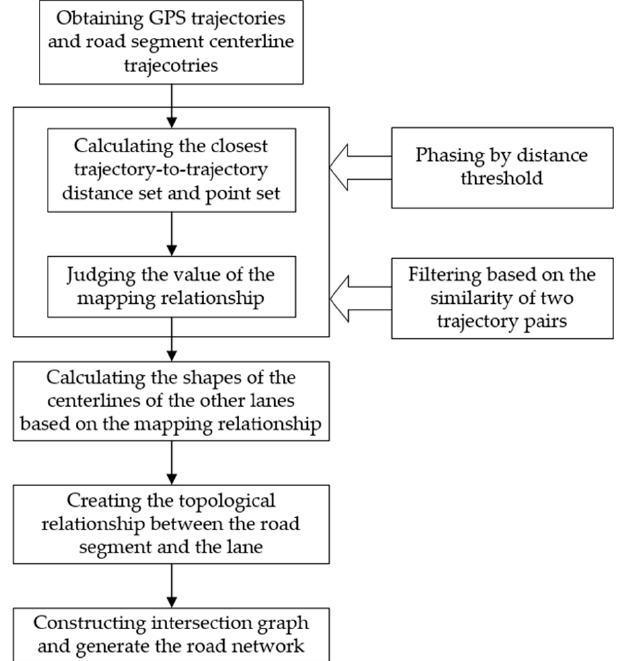
Figure4. TSJ-pruning-basedalgorithm. Note: Globalpositioningsystem(GPS)andtrajectory-similarity- Figure 4. TSJ-pruning-based algorithm. Note: Global positioning system (GPS) and trajectory- join similarity-join (TSJ).